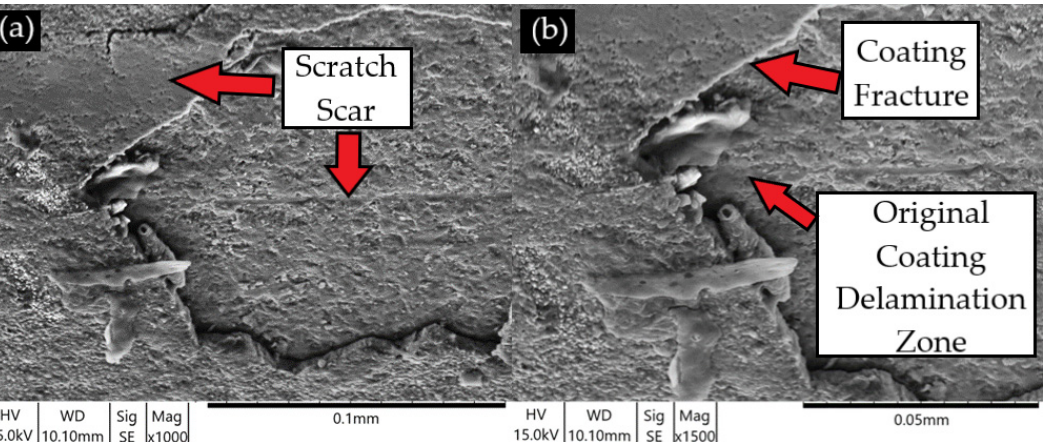
Figure 19. ( a ) Coating A scratch position 1 (initial scratch L c1 ) at ×1000 magnification and ( b ) Coating A scratch position 1 (initial scratch L c1 ) at ×1500 magnification.